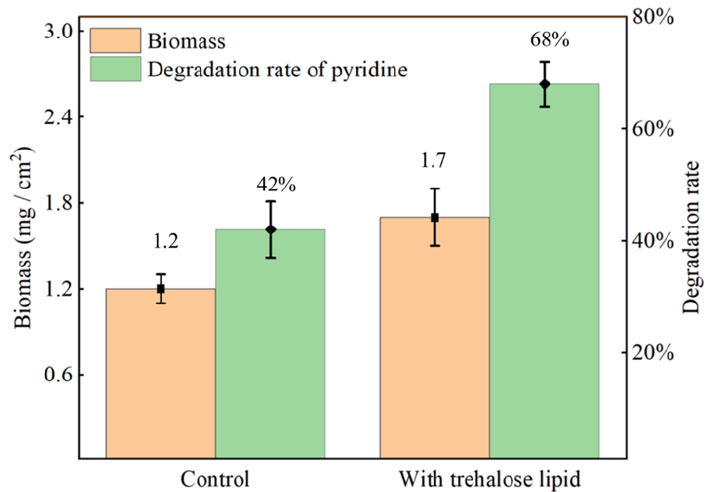
Figure 5. Biomass and degradation rate comparison with and without trehalose lipid; the operation condition was set at 30 °C, neutral and the pyridine concentration was 2 g/L. Biomass was evaluated by protein content; the addition of trehalose lipid was 20 mg/L.